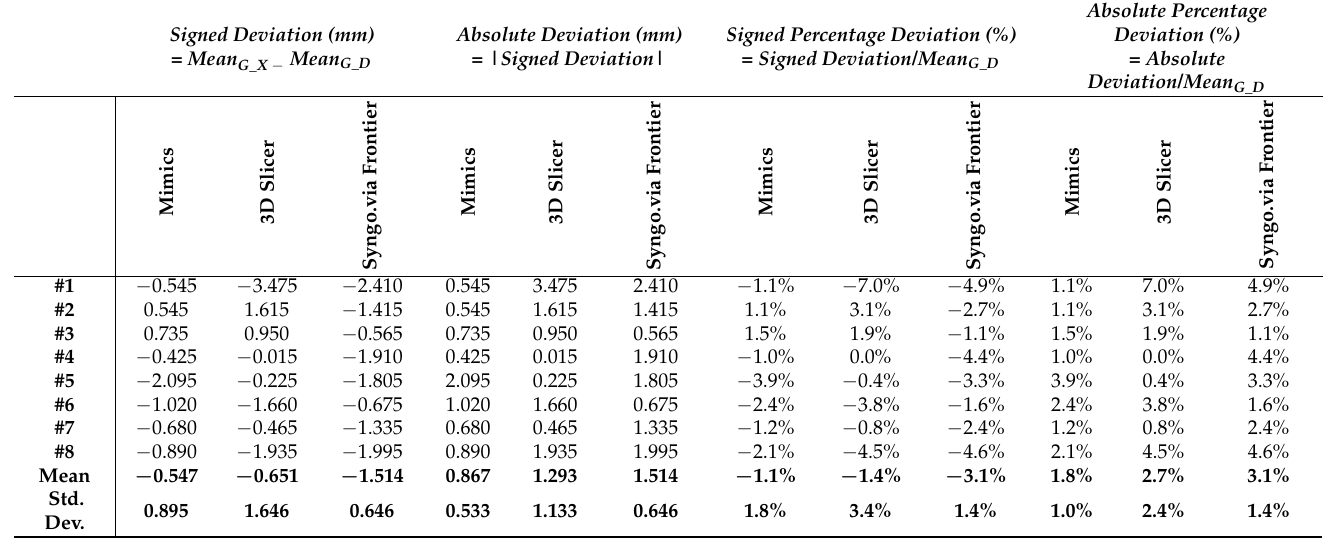
Table 4. Signed and absolute deviations for horizontal and vertical femoral head diameters obtained from the three segmentation software.